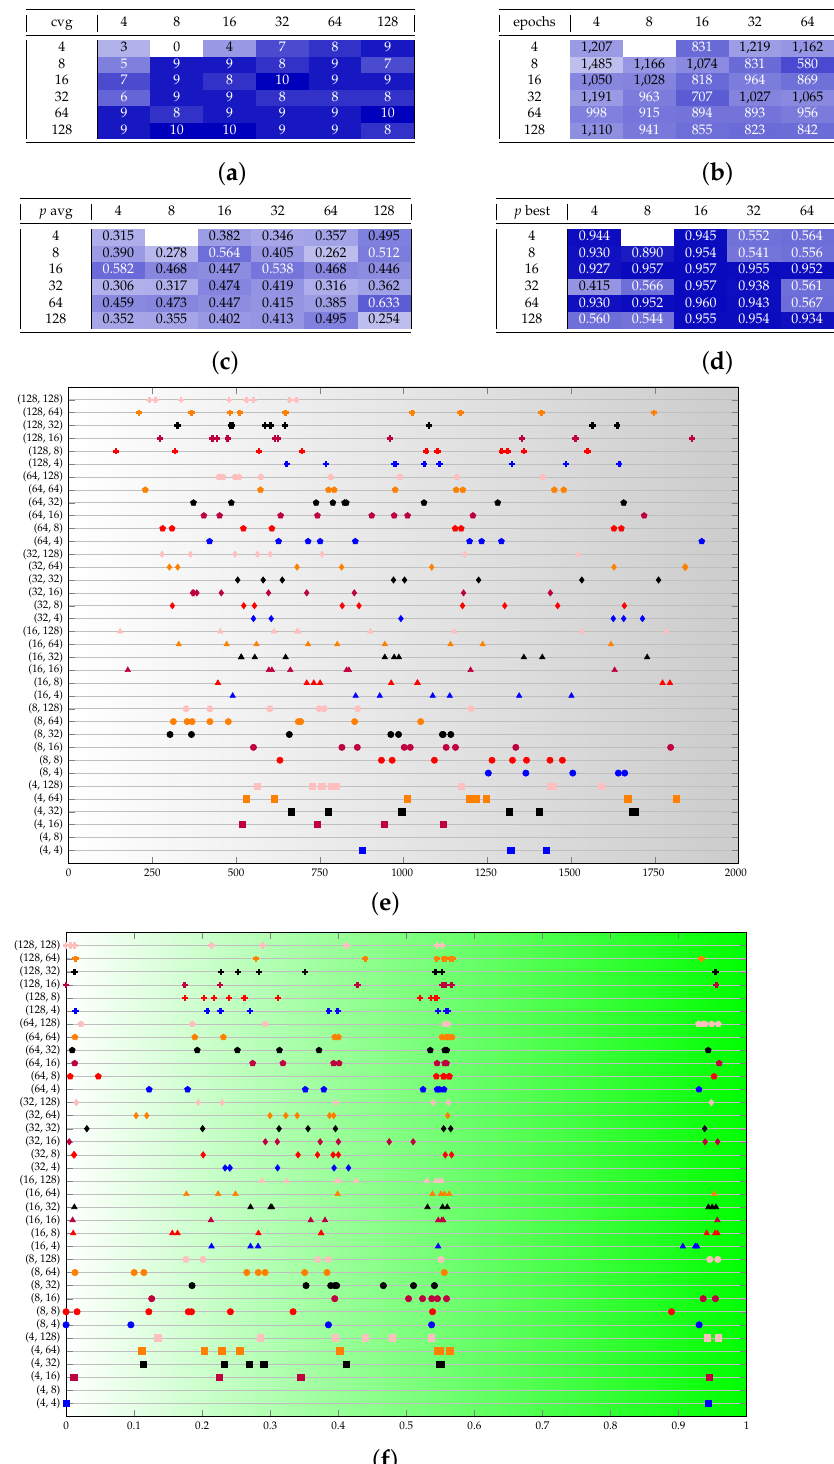
FigureA4. ThetestsetCprovidesasensitivityanalysisonthediscriminatorsize. InSubfiguresA4a-A4dtherowsrepresent H 1 and Figure A4. Test set C provides a sensitivity analysis on the discriminator size. ( a – d ) The rows thecolumns H 2 . InSubfiguresA4e-A4f,thecouplesontheverticalaxisare ( H 1 , H 2 ) ,markershapesrepresent H 1 andmarkercolors represent H 2 . represent H 1 and the columns H 2 . ( e , f ) The couples on the vertical axis are ( H 1 , H 2 ) . Marker shapes represent H 1 and marker colors represent H 2 . ( a ) Converging runs, out of 10. ( b ) Number of epochs before convergence, on average. ( c ) p -value for the χ 2 test once convergence is reached (average over converging runs). ( d ) p -value for the χ 2 test once convergence is reached (best run). ( e ) Visual representation of the epochs before convergence. ( f ) Visual representation of the p